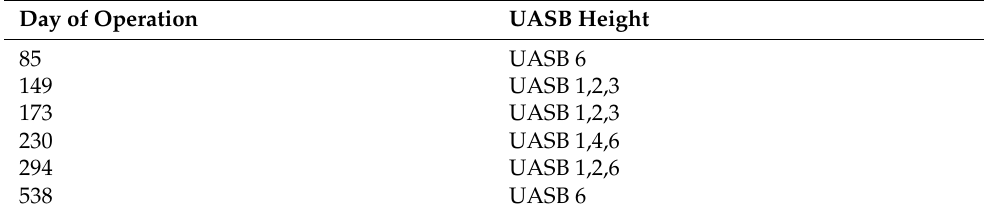
Table 1. Biomass sampling events during the long-term operation of the UASB reactor. Day of Operation UASB